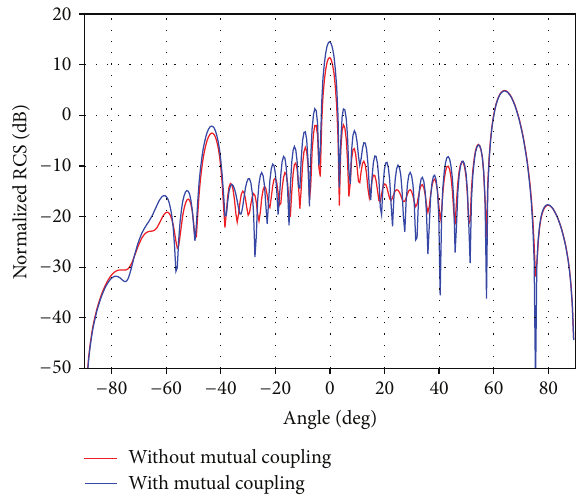
Figure 16: Scanned RCS of a series-fed 40-element linear dipole array in side-by-side configuration with Taylor amplitude distribu- tion ( 𝜃 𝜎 = 65 ∘ ).